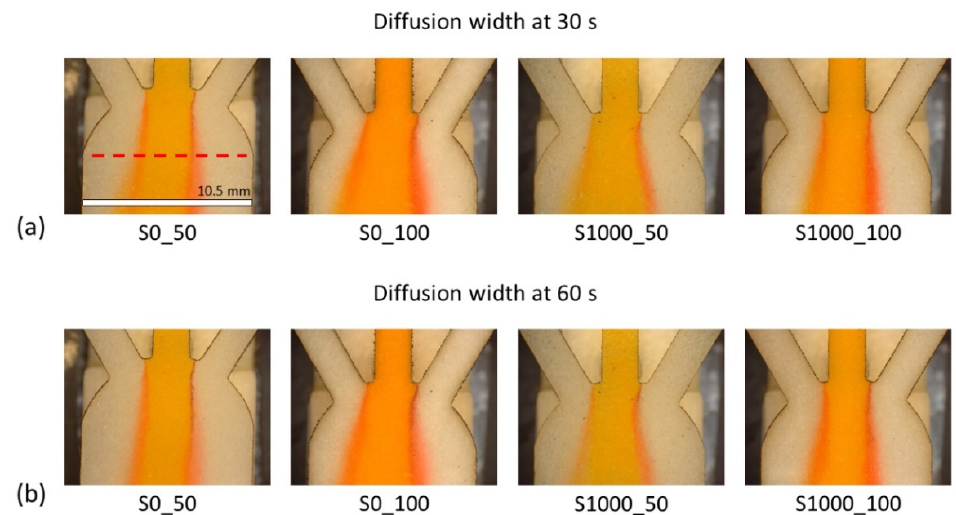
Figure 10. Visual comparison of diffusion development in different lab-made Sisal papers at ( a ) 30 s and ( b ) 60 s after the “Time zero”. The measurement line is displayed as the dashed line. Scale = 10.5 mm.